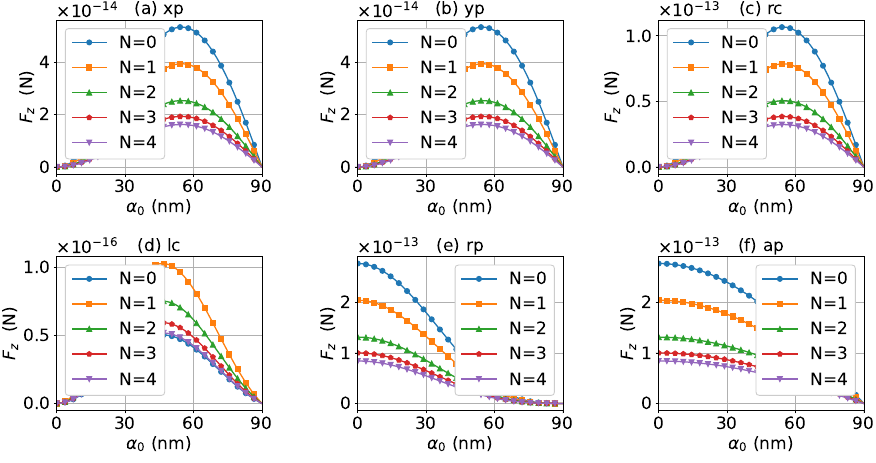
Figure 19. The same as in Figure 18, but with l =